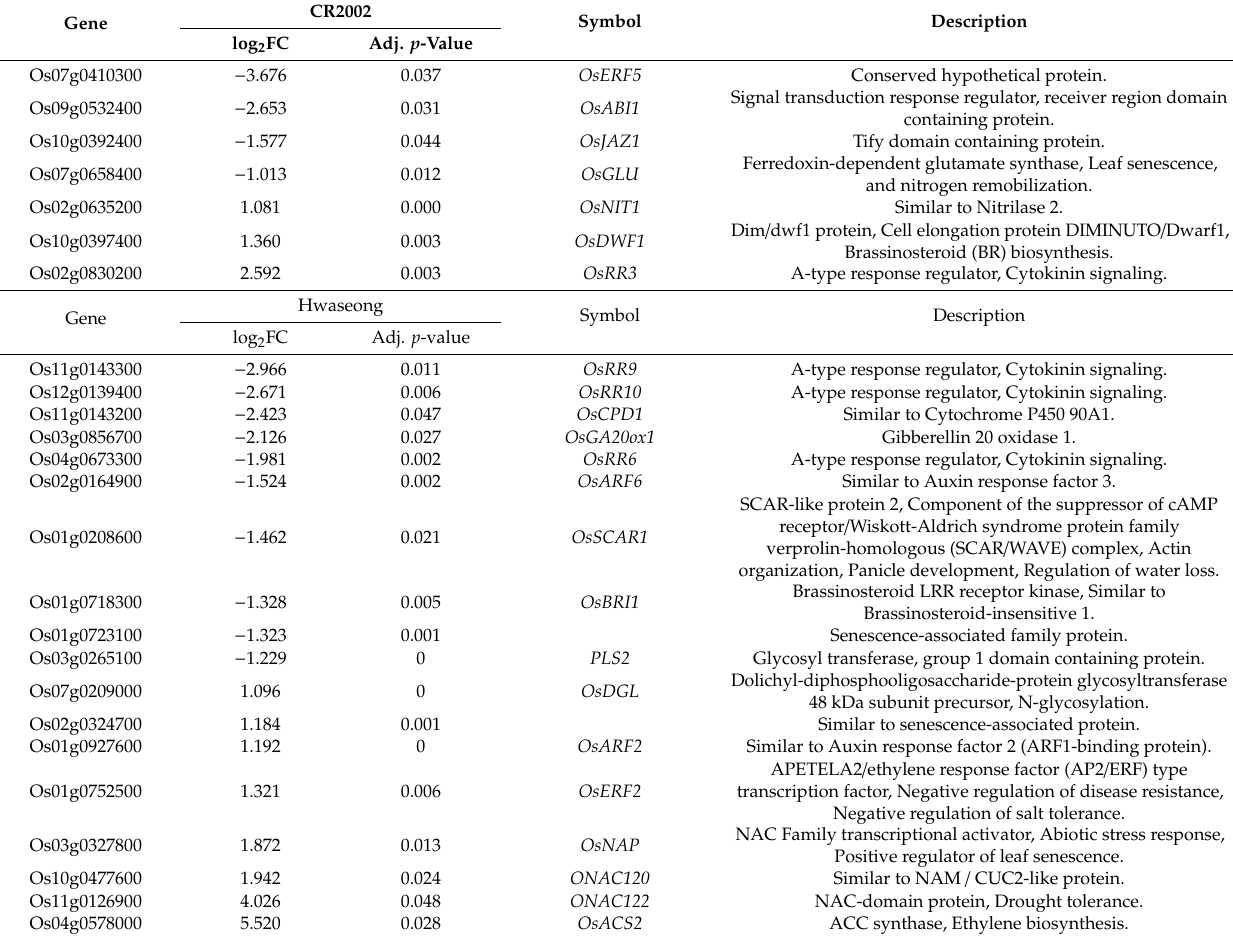
Table 3. List of di ff erentially expressed genes (DEGs) associated with senescence, chlorophyll degradation, and phytohormone specifically detected in CR2002 and